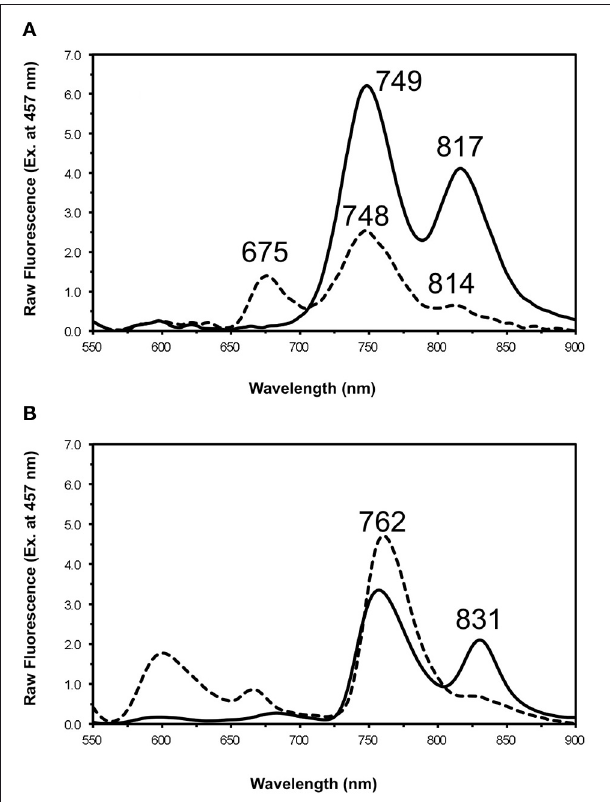
FIGURE 10 | Fluorescence emission spectra for chlorosomes from C. limnaeum bchU mutant at room temperature (panel A) and 77K (panel B). The excitation wavelength was 446nm for each. Spectra of oxidized chlorosomes (dotted lines) were recorded in air-saturated buffer. The spectra of reduced chlorosomes (solid lines) were recorded after treatment with 25mM sodium dithionite and incubation in the dark for